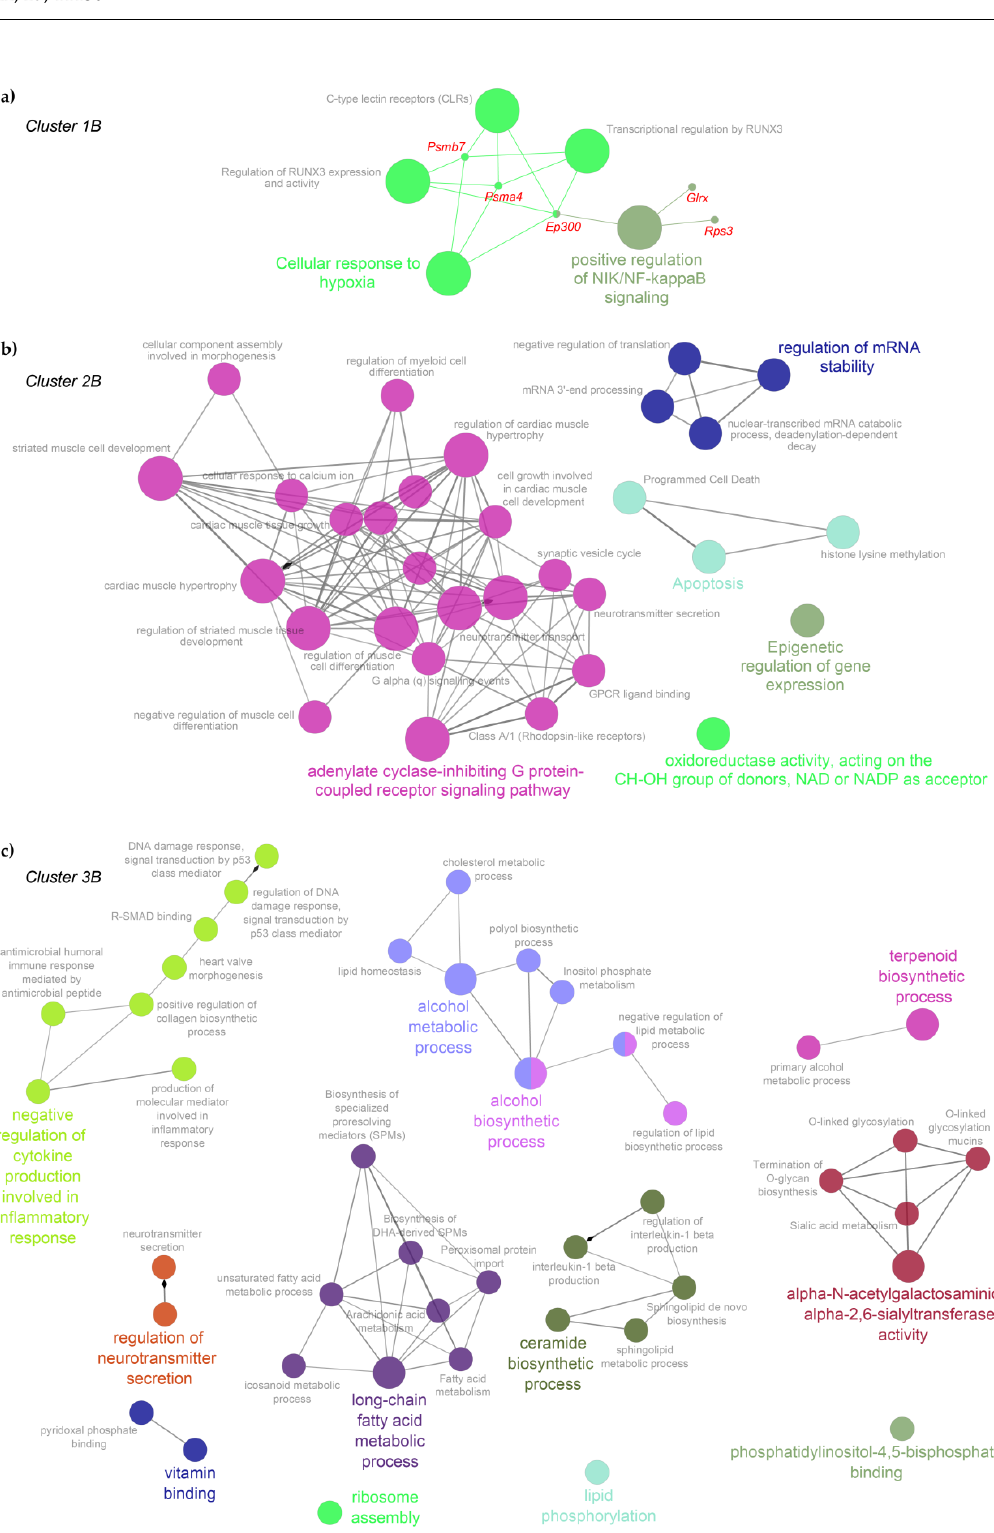
Figure 6. Enrichment networks in Middle Age animals for clusters 1B ( a ), 2B ( b ), and 3B ( c ). The networks show the most significant gene ontology (GO)-biological processes (BPs)/pathways (adjusted p -Value < 0.05) enriched in the transcript clusters identified by hierarchical clustering. Colors refer to groups of gene sets with related biological functions. Node size relates to gene-set